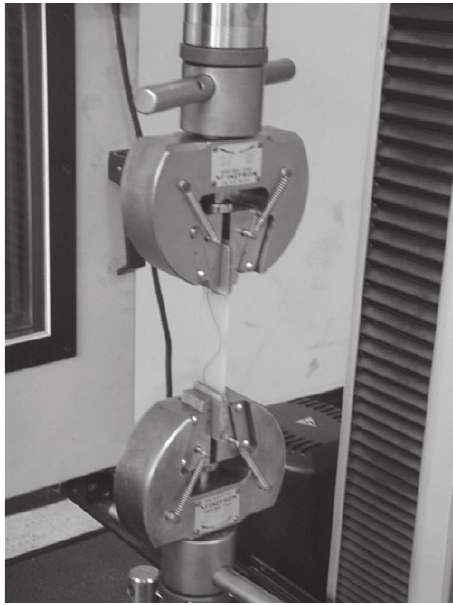
Figure 3 Experimental settings of the FRE specimen.